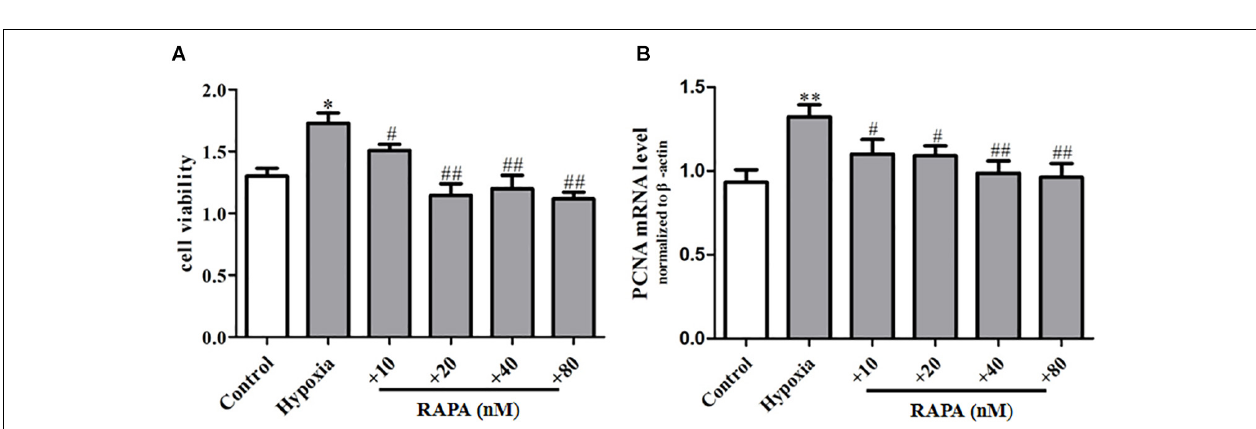
FIGURE 4 | Rapamycin can inhibit PASMC senescence by inhibiting the activation of mTOR/S6K1 signaling in hypoxia-treated PASMCs. (A) The protein expression of p-mTOR and mTOR was determined by Western blot in PASMCs. (B) The protein expression of p-S6K1 and S6K1 was determined by Western blot in PASMCs. (C) The protein expression of p16 was determined by Western blot in PASMCs. Data are mean ± SEM, n = 3. ∗ P < 0.05 vs. control, # P < 0.05 vs. hypoxia, ## P < 0.01 vs. hypoxia.